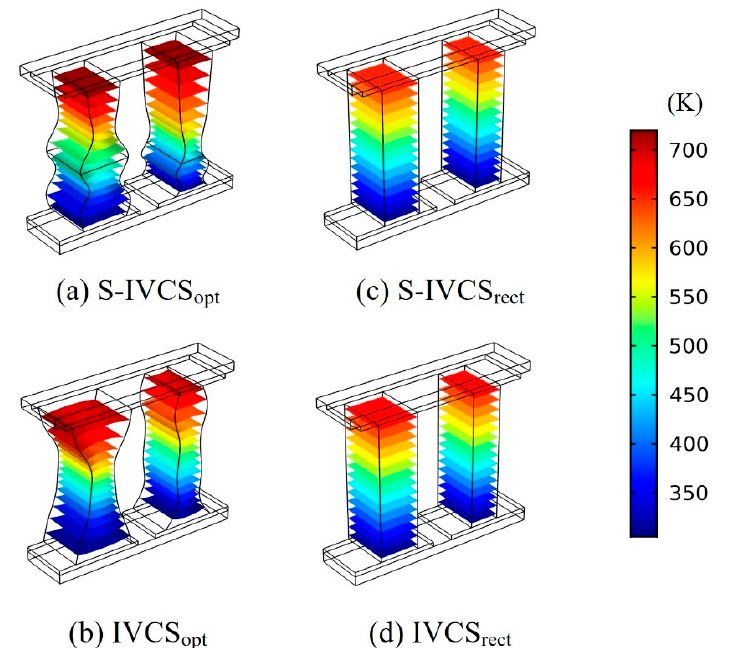
Figure 14. Temperature contour comparison between the four designs.